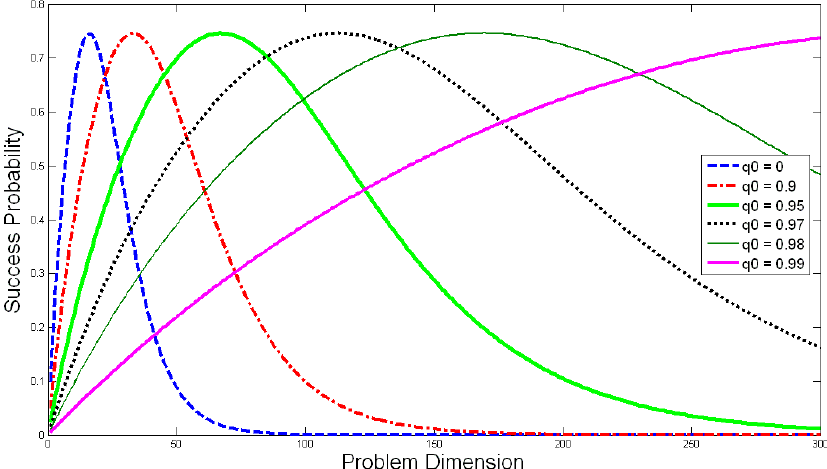
Figure 3. Influence of problem dimension and q 0 on success probability of the proposed PSO.